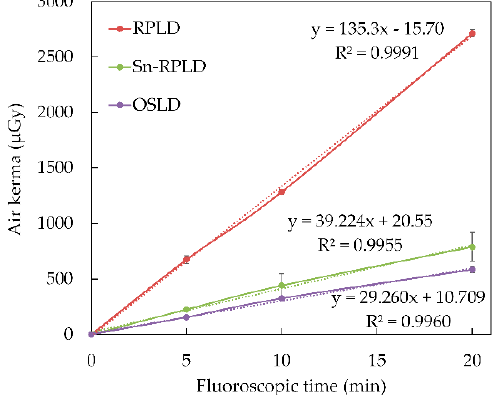
Figure 5. The accumulated air kerma of small dosimeters as a function of fluoroscopic time.